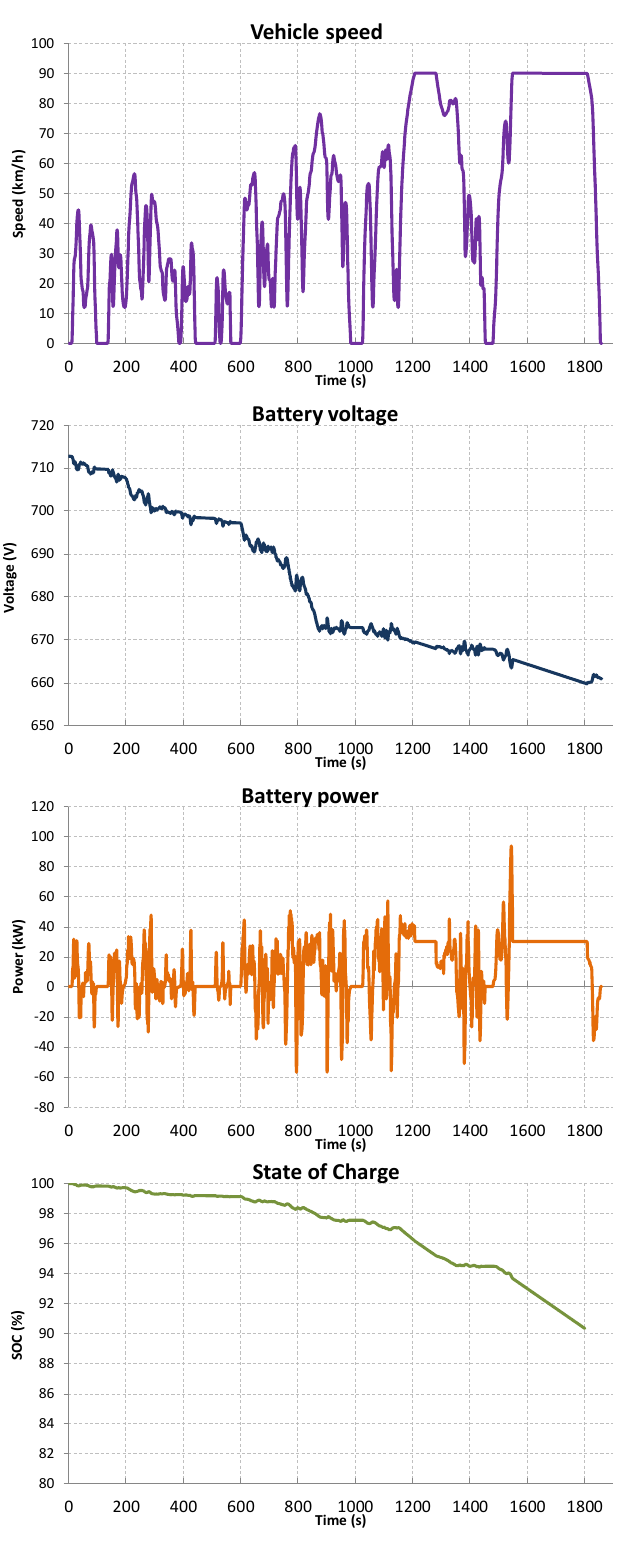
Figure 14. WLTC 3a-90-results of simulation tests for the 4 × 2 drive system.